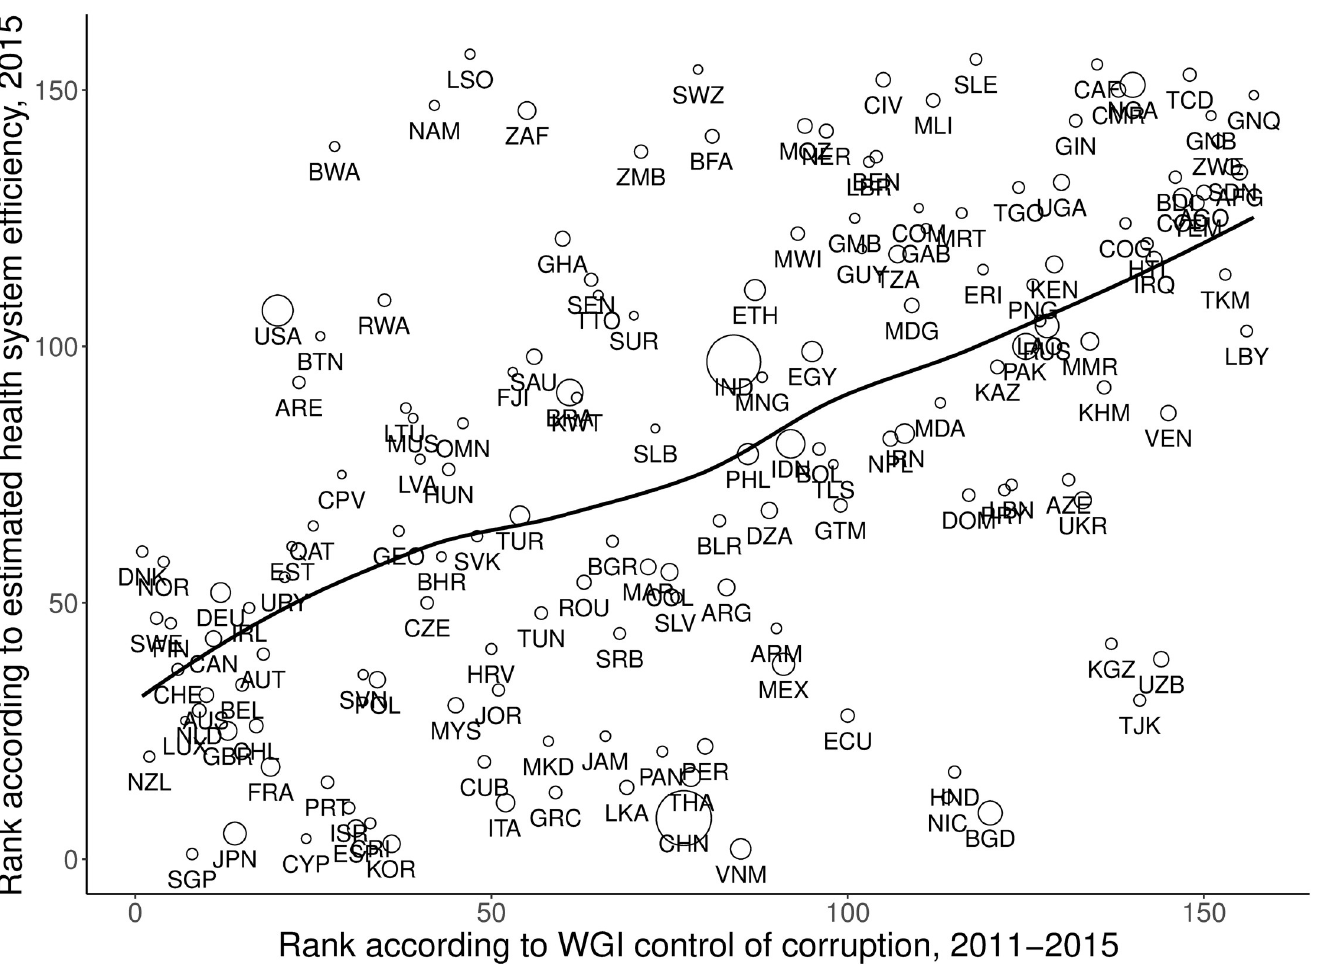
Fig 3. Relationship between ranking of countries according to estimated health system efficiency and control of corruption (n = 157). Note: The figure shows only countries with available data on both health system efficiency and control of corruption ( n = 157). The full set of 158 countries was included in estimation of the SFA model. The sizes of the circles represent total population